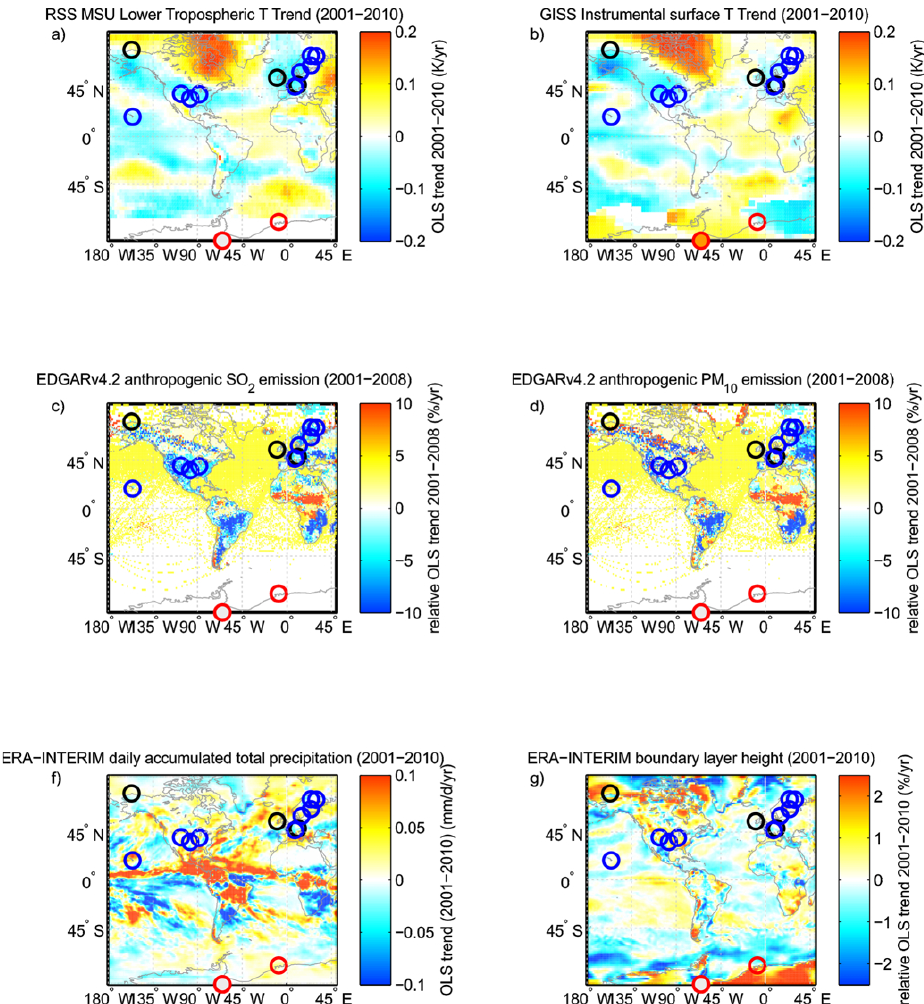
Fig. 5. Comparison of different potential explanatory mechanisms for GLS/ARB N trends 2001–2010, blue symbols indicate statistically significant decreasing trends, red symbols s.s. increasing trends and black symbols indicate no s.s. trend. For DMPS datasets N20 was used. Comparison trends were calculated with OLS. (a) RSS Lower troposphere temperature from satellite microwave sensors; (b) GISS surface instrumental temperature trend; (c–d) EDGARv4.2 emission inventory trends for SO 2 and PM 10 , note the period from 2001–2008; (e–f) ERA-Interim re-analysis trends for 2001–2010 for monthly mean of daily forecast accumulated total precipitation and boundary layer height. South Pole station shown at middle lower edge of the